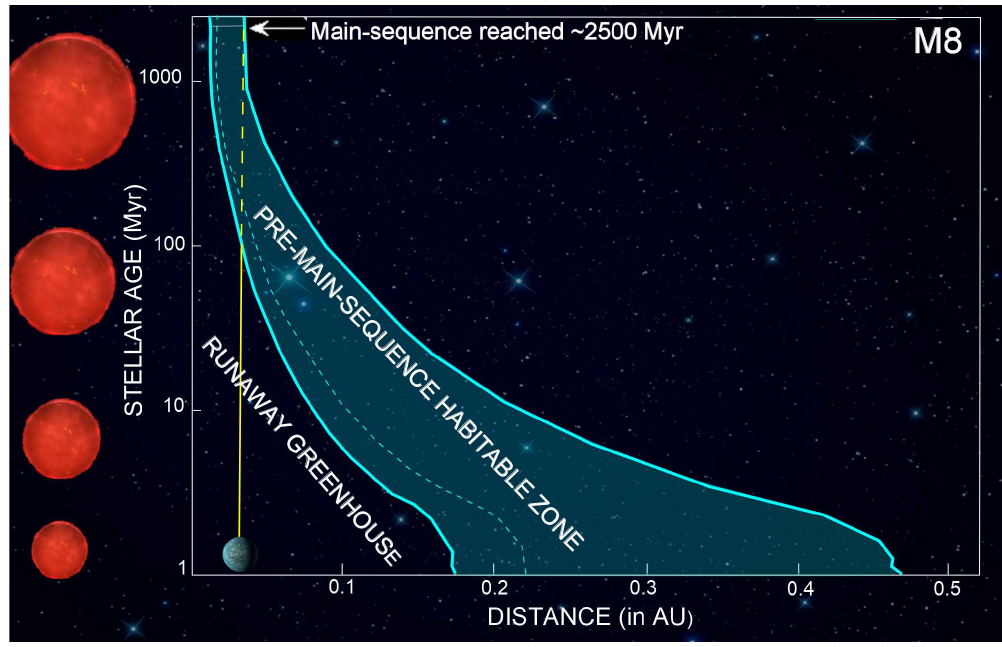
Figure 11. The pre-main-sequence habitable zone for an M8. A planet originally located at 0.03 AU undergoes a runaway greenhouse for ~100 Myr before settling near the outer edge of the habitable zone at the start of the main-sequence. Based on work from Ramirez and Kaltenegger [51].